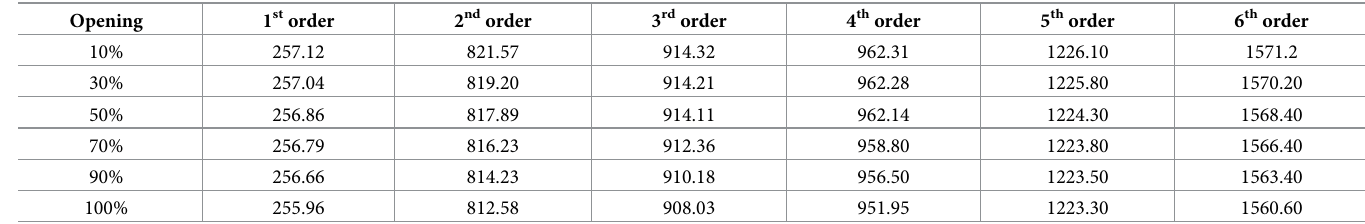
Table 5. Modal frequencies of the valve.